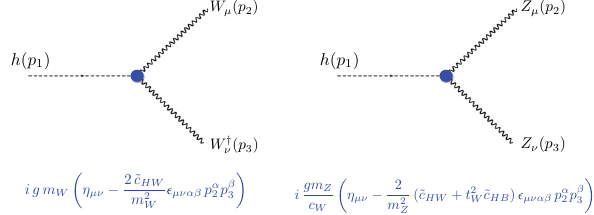
Fig. 1 Feynman rules associated with dimension-six CPV operators involving a Higgs boson and a pair of weak bosons